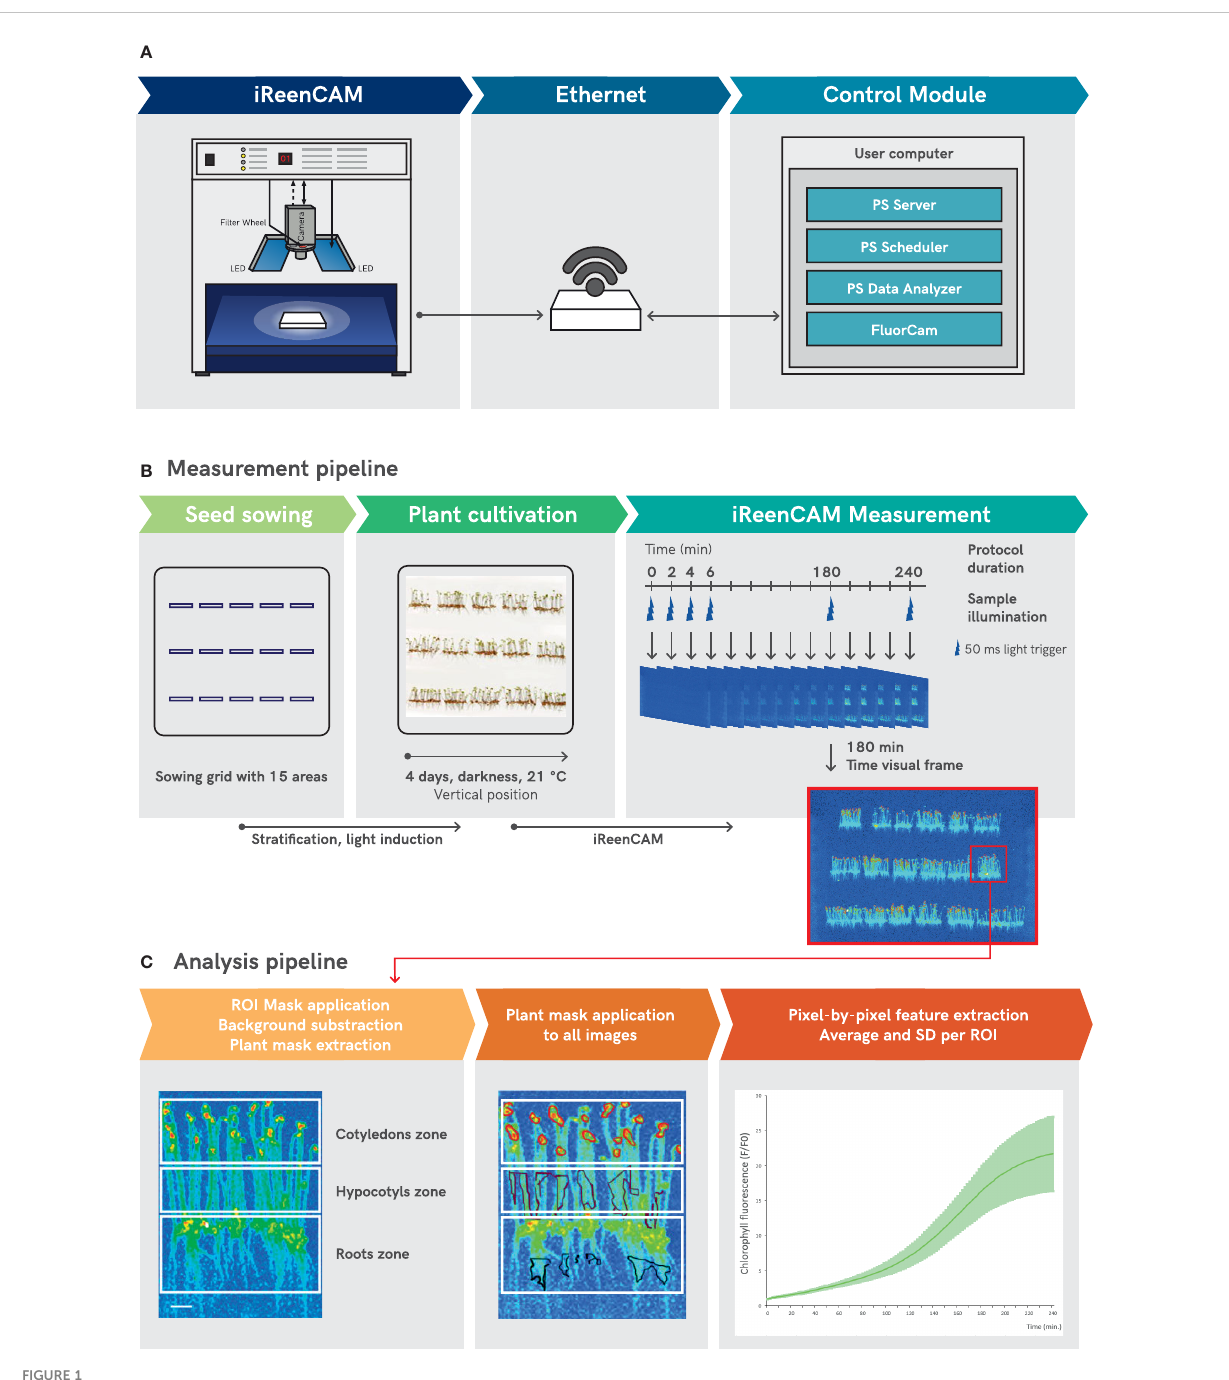
FIGURE 1 The scheme of iReenCAM measurement and analysis pipeline. (A) Comprehensive control module for automatic and programmable image acquisition and data management based on PlantScreen ™ phenotyping SW toolbox organizes the operation of the entire iReenCAM system by controlling and synchronizing the HW operation with user de fi ned measurement and analysis protocol. (B) Measurement pipeline consists of grid- de fi ned seed sowing, followed by strati fi cation, light induction and vertically oriented Petri plate cultivation. The measuring protocol allows dynamic measurements of the fl uorescent images of a sample in 2-minute intervals for 4 hours in total, i.e. 120 measuring rounds. Time visual frame of representative false-color image of vertically oriented 4-day-old Arabidopsis seedlings acquired at time 180 min is used for ROI mask generation. (C) Mask de fi ning ROI for cotyledon, hypocotyl and root zone is applied on time visual frame, further background subtraction is performed and plant mask is extracted. Next plant mask for the zone of interest of the seedlings is applied to images from all measured rounds and pixel by pixel fl uorescence values for each ROI from all measured rounds is extracted. Finally, mean and SD values for given ROI (here for cotyledons only) was calculated (n=9) of raw data ( fl uorescence F) normalized to the mean fl uorescence value at T0 (F0). Scale bars = 1 cm (A) and 0.25 cm (C)